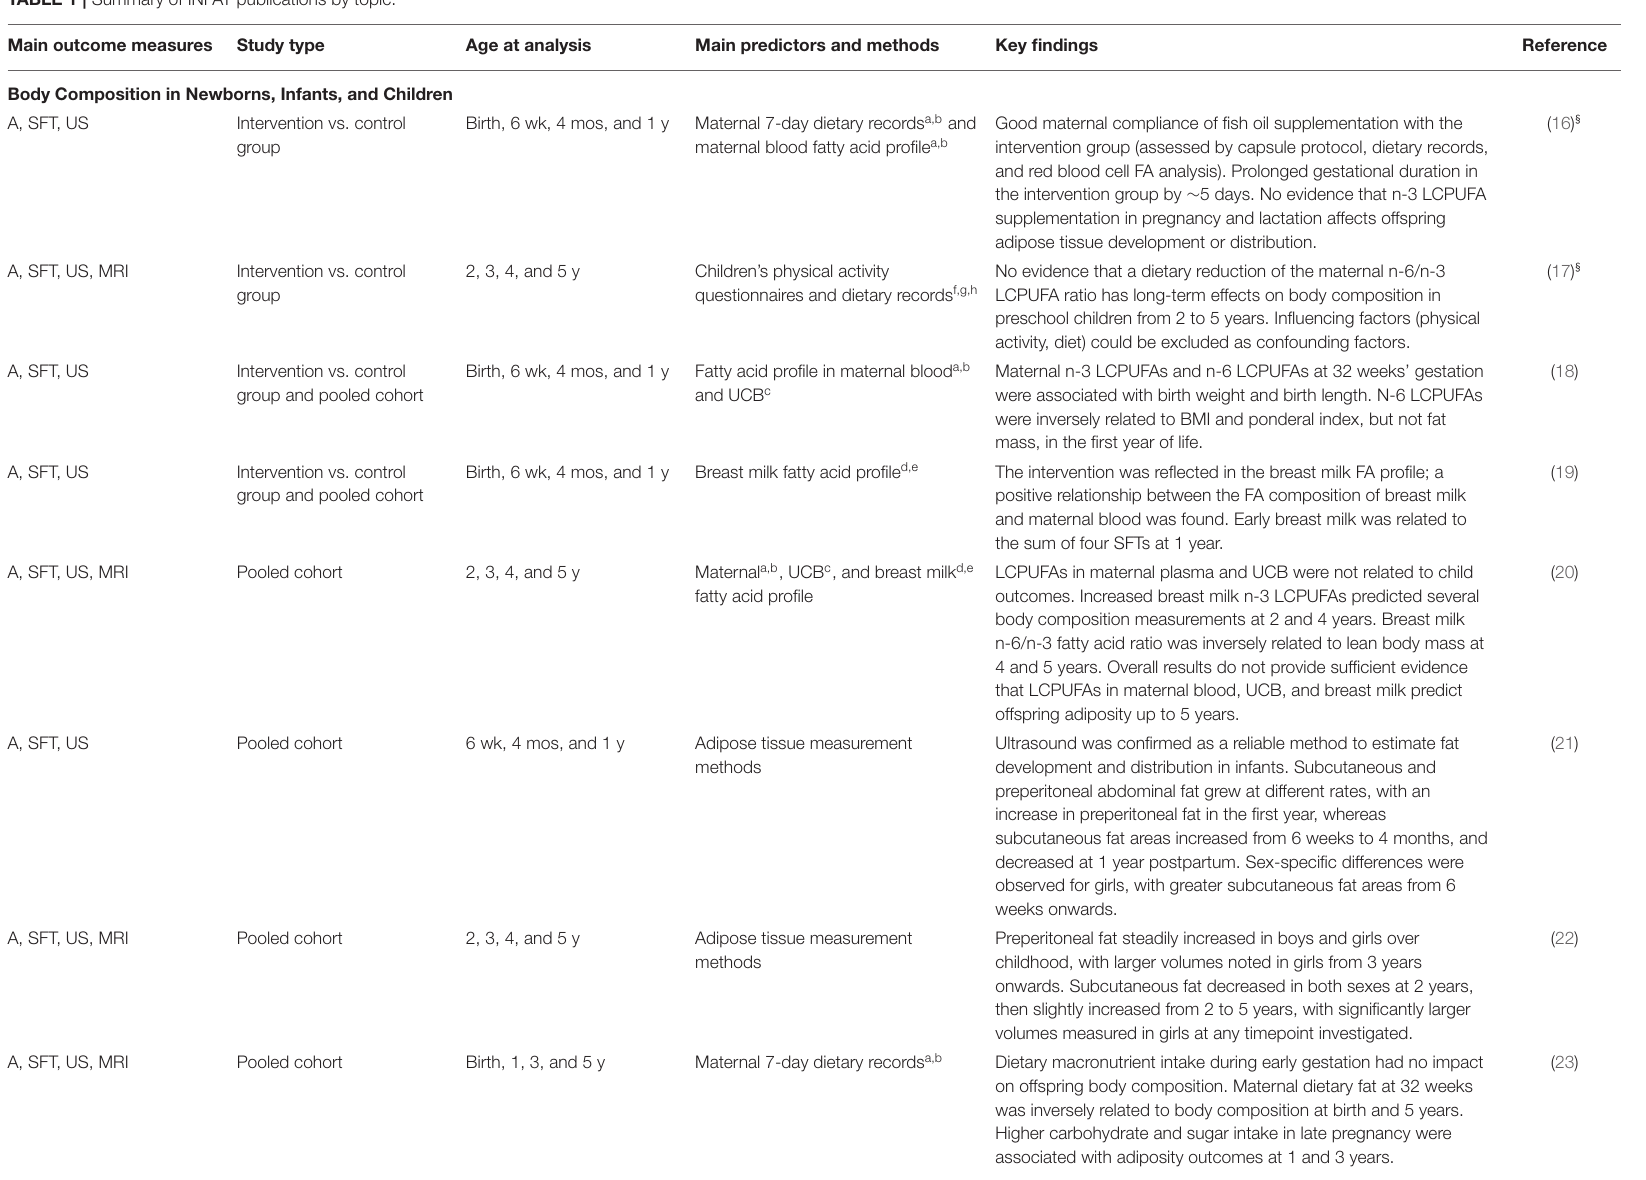
TABLE 1 | Summary of INFAT publications by